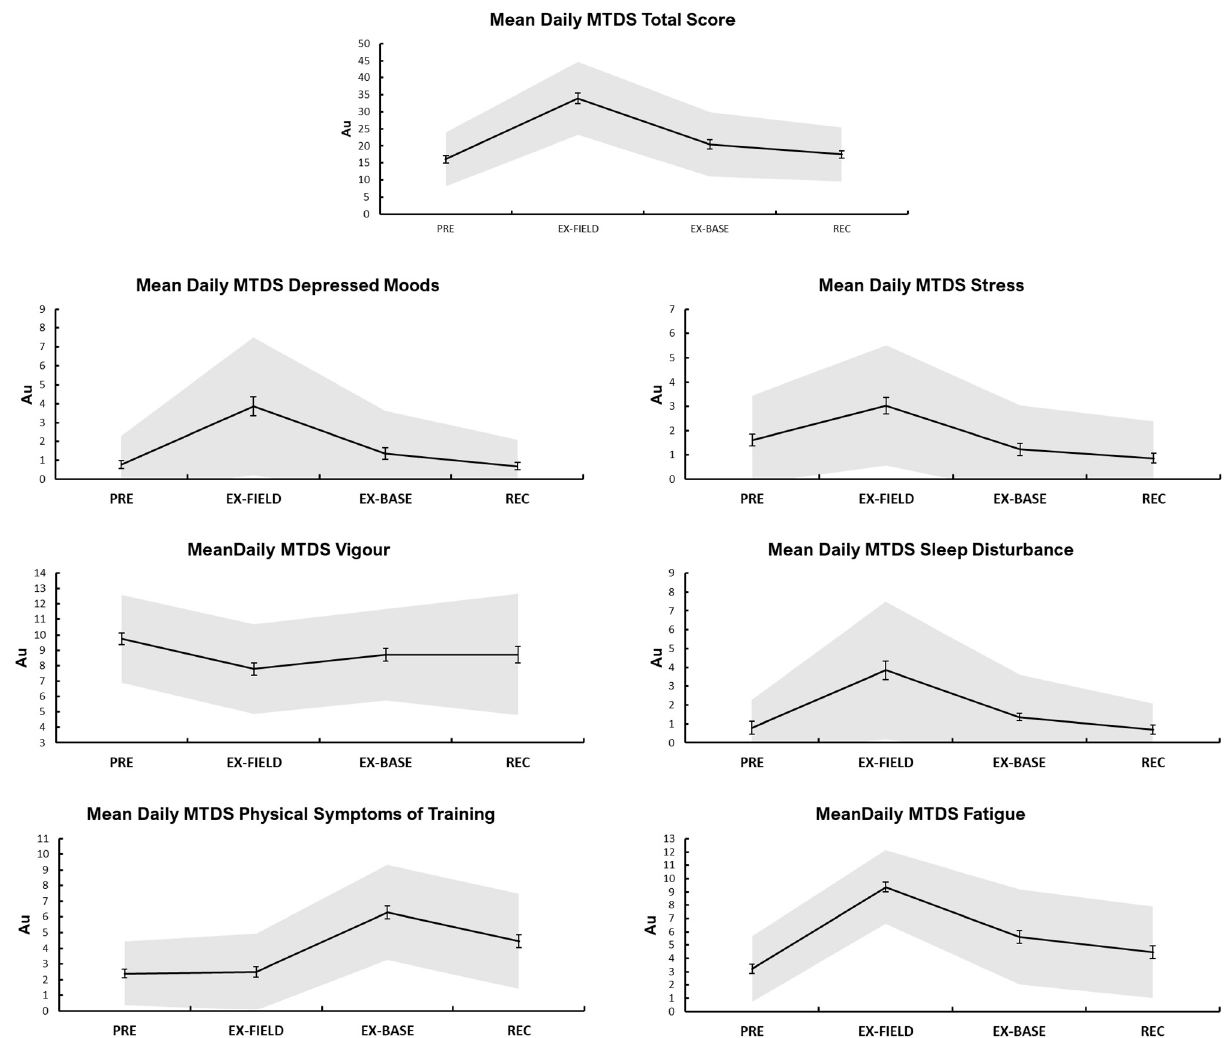
Figure 3. Means per study phase (±SE) for well-being. NOTE: MTDS, Multi-component training distress scale; Au, arbitrary units. All variables significantly affected by time over the four study phases.